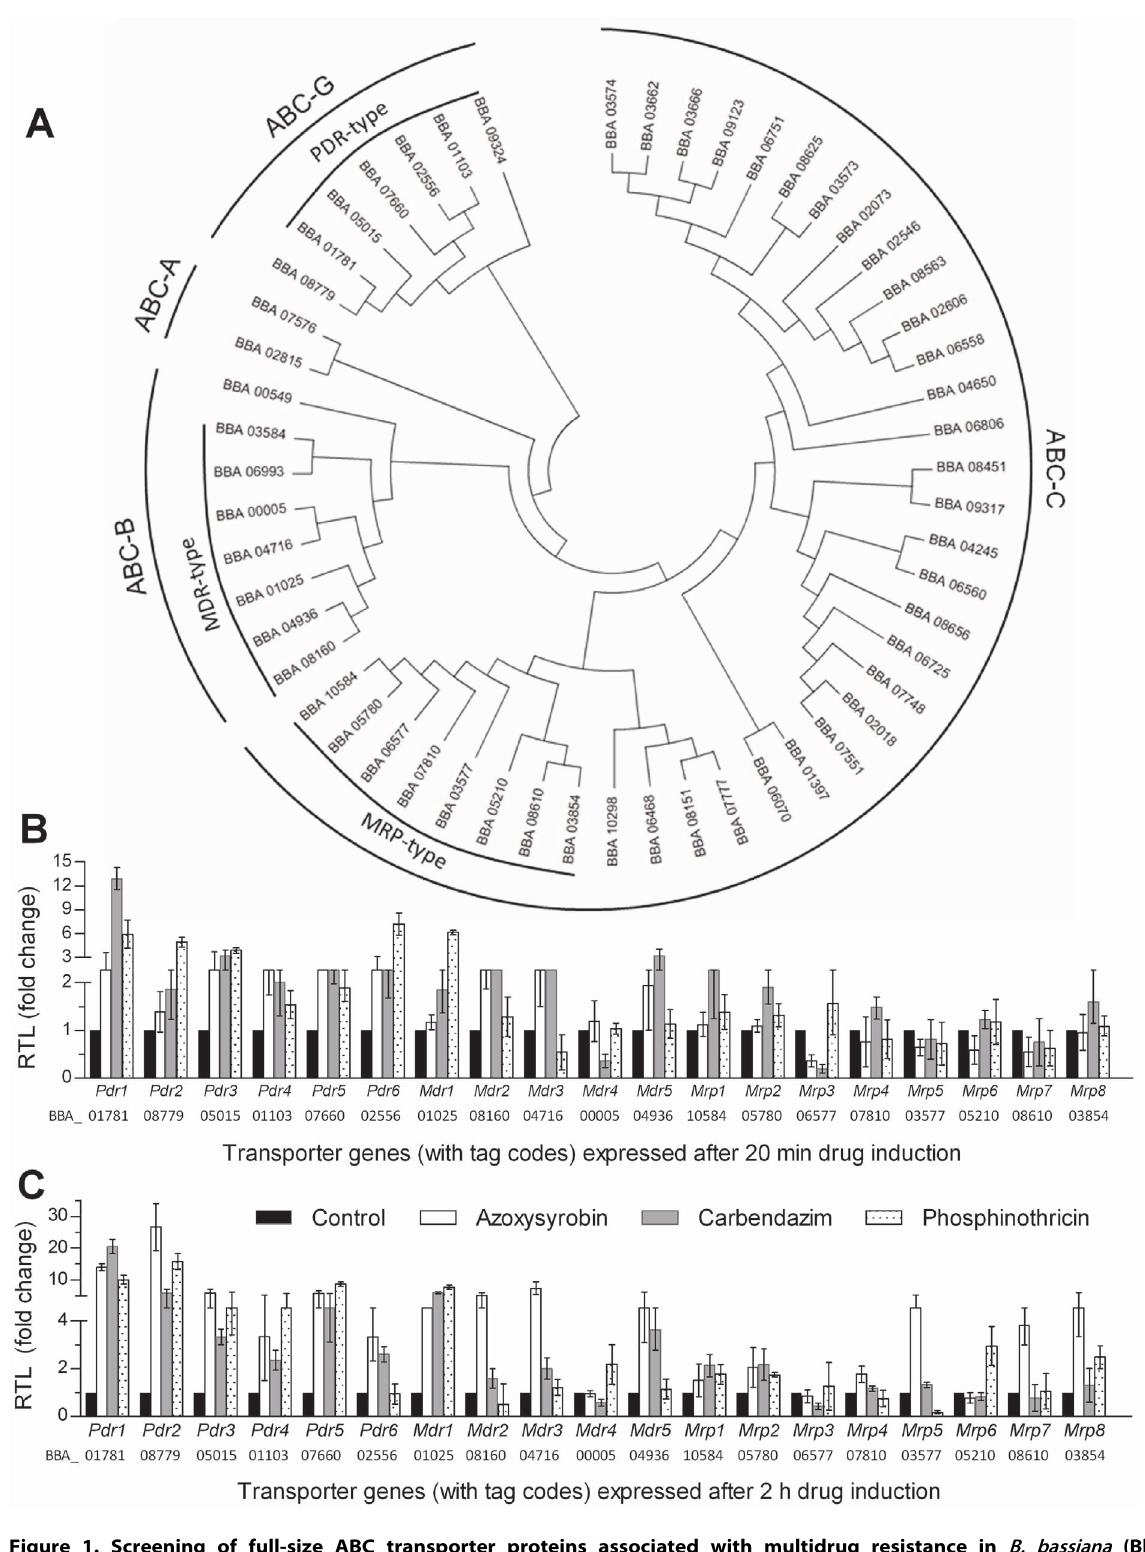
Figure 1. Screening of full-size ABC transporter proteins associated with multidrug resistance in B. bassiana (Bb2860). (A) Phylogenetic analysis of 54 full-size ABC proteins. (B), (C) Relative transcript levels (RTL) of 21 ABC transporter genes in the wild-type SDB cultures induced with carbendazim (5 m g/ml), azoxysyrobin (100 m g/ml) and phosphinothricin (100 m g/ml) for 20 min and 2 h at 25 u C respectively. Error bars: SD of the mean from three cDNA samples assessed via qRT-PCR with paired primers (Table S1).